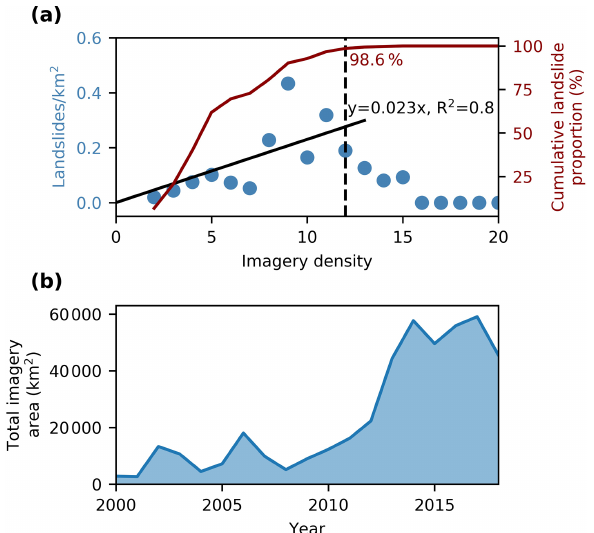
Figure 9. The impact of imagery density (the number of available images in © Google Earth) on the number of observed landslides. We only show the results for the rocks of Category III (Sect. 4.1). Therefore, major cities that are characterized by a high imagery den- sity like Bukavu, Bujumbura, and Goma are excluded from this fig- ure. (a) Impact of the imagery density on the number of observed landslides. The number of landslides seems to increase linearly with imagery density up to 12 images. The cumulative landslide propor- tion for a certain value shows the percentage of the landslide inven- tory contained in areas with an imagery density equal or lower than that value. (b) The evolution of imagery availability between 2000 and 2018.